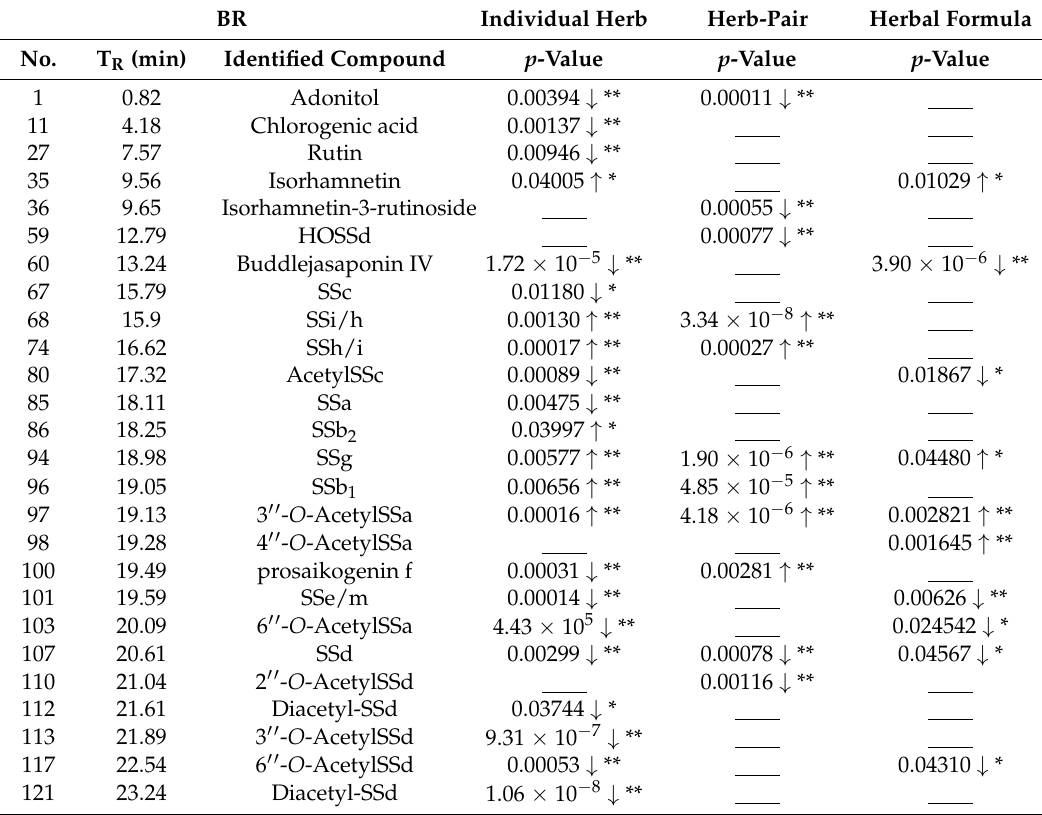
Table 2. Results of the t -test of 26 peaks from BR showing significant difference in individual herb, herb-pair, and complicated Chinese herbal formula before and after processing ( n = 6). BR Individual Herb Herb-Pair Herbal